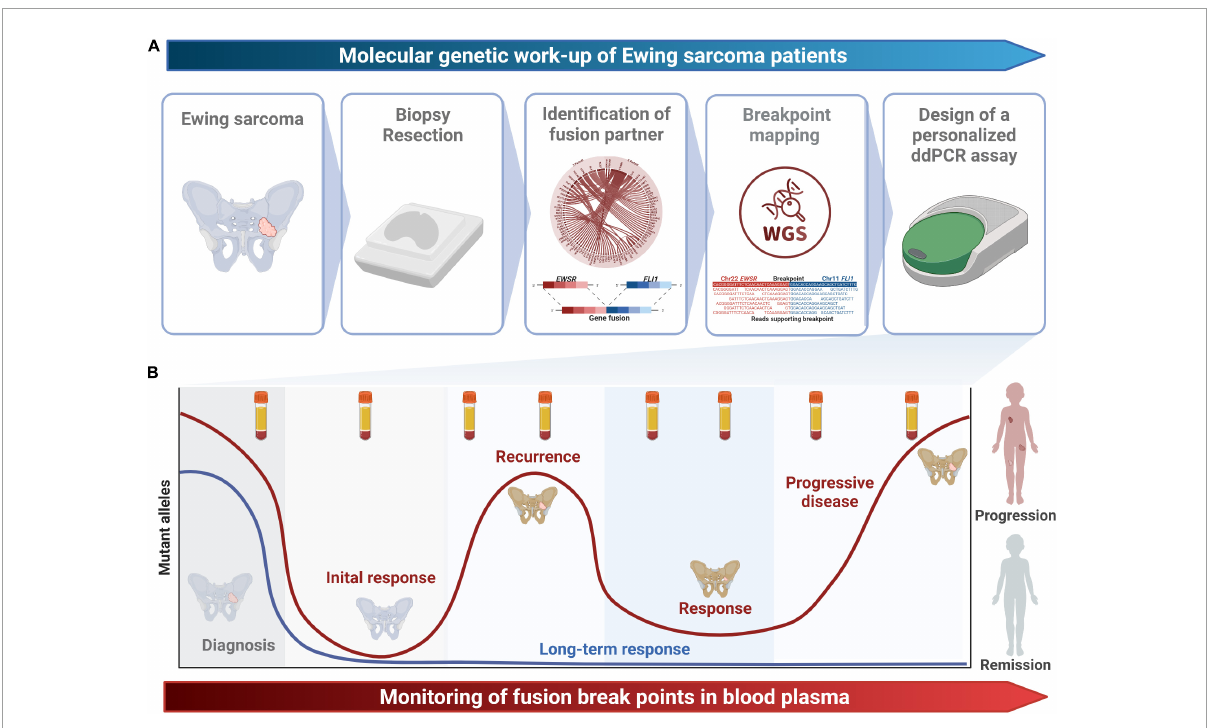
FIGURE1 Study design. (A) The molecular genetic work-up from tissue sampling to the design of a patient-specific ddPCR assays spanning the fusion breakpoint is shown. (B) Longitudinal monitoring of fusion breakpoints in blood plasma enables early detection of recurrence and progression and might guide treatment